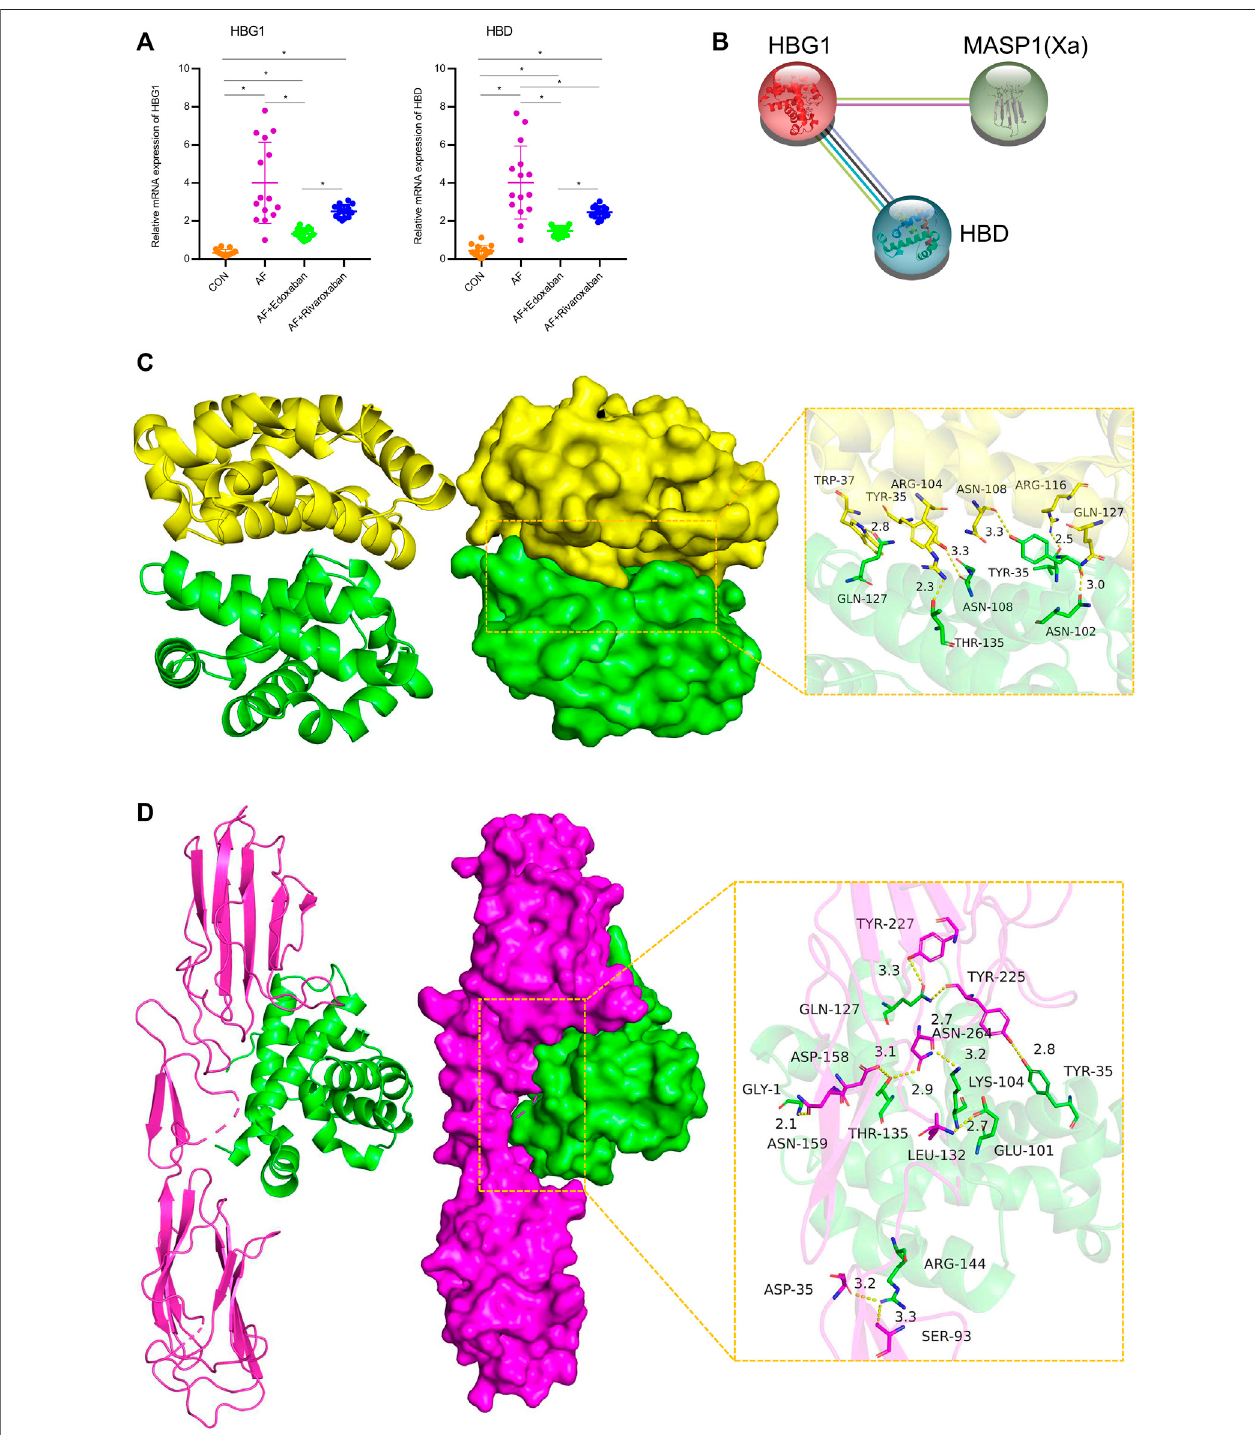
FIGURE 7 | mRNA expressions of HBG1 and HBD via the RT-PCR and the interaction between HBG1, HBD, and MASP1 (Xa). (A) In the PCR assay, the results showed that the expressions of HBG1 and HBD in the AF + edoxaban group were lower than in the AF + rivaroxaban group. (B) There exists a signi fi cant interaction between HBG1, HBD, and MASP1(Xa). (C) Binding mode of the complex HBG1 with HBD. The backbone of protein was rendered in tube and colored in green (HBG1) andyellow(HBD).HBG1andHBDproteinsarerenderedbythesurface.ThedetailbindingmodeofHBG1withHBD.Yellowdashrepresentsthehydrogenbondor salt bridge. (D) Binding mode of the complex HBG1 with MASP1. The backbone of protein was rendered in tube and colored in green (HBG1) and red (MASP1). HBG1 and MASP1 proteins are rendered by the surface. The detailed binding mode of HBG1 with MASP1. Yellow dash represents the hydrogen bond or salt bridge.